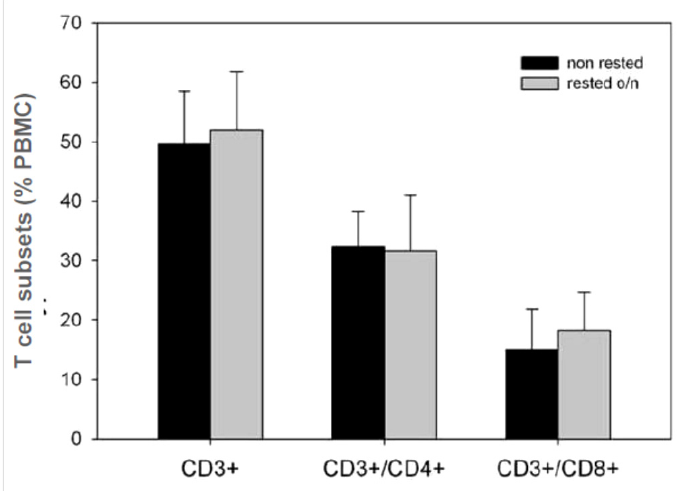
Figure 6. Frequencies of T cells and the CD4/CD8 subpopulations in PBMC before and after 20 h resting determined by flow cytometry. For all 25 donors, the percentages of CD3 + , CD3 + /CD4 + , and CD3 + /CD8 + cells were established once before (black bars), and once after (grey bars), resting. The mean and SD for the 25 PBMC of both groups are